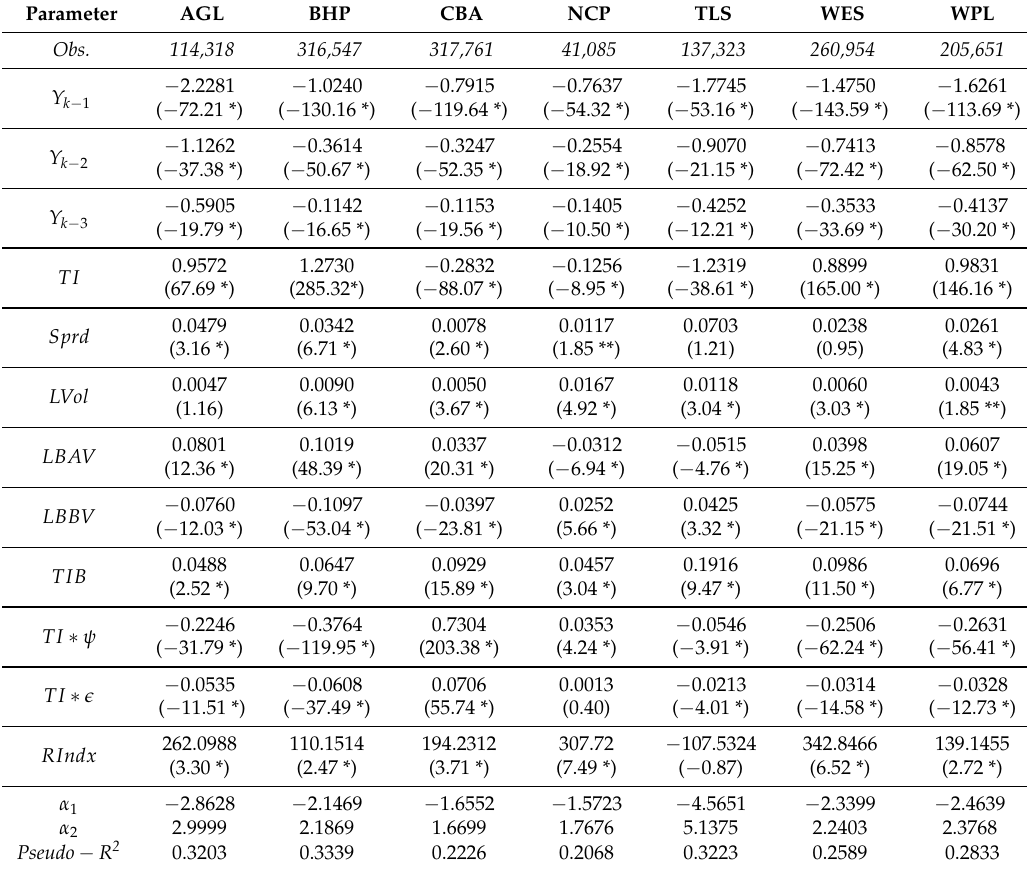
Table 3. Coefficient estimates β i , of ordered probit model on direction of price change based on 12 explanatory variables for the selected stocks. The sampling period was 16 January 2014 to 15 January 2014. Z statistics are given within parentheses for each